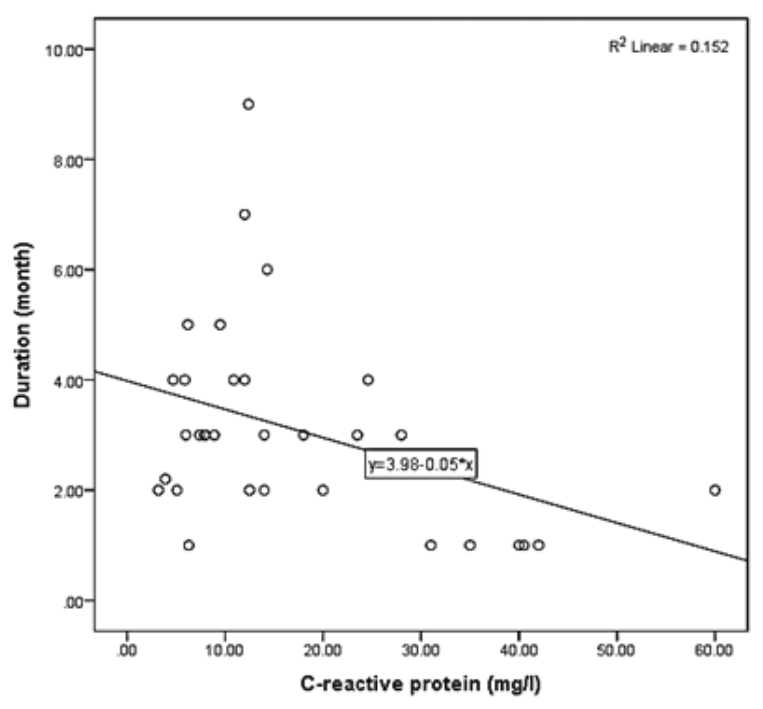
Figure 1: Relationship between C-reactive protein and the duration of CHIKV disease